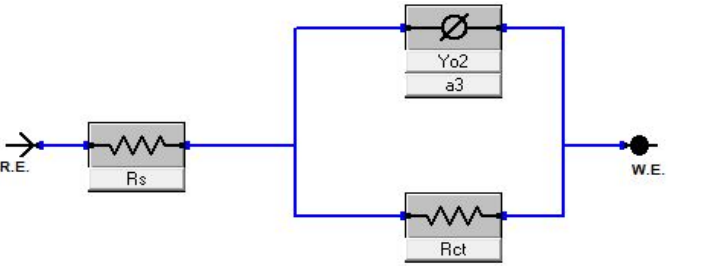
Figure 10. EIS electrical model representative of the physical quantities in a half ‐ cell 3 ‐ electrode.